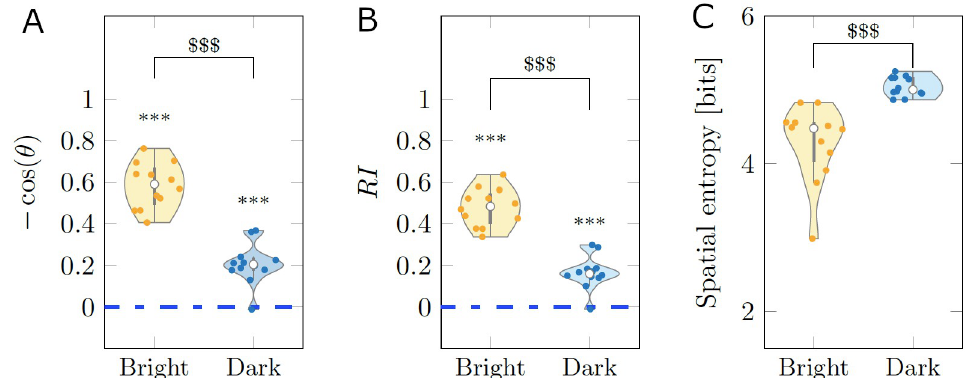
Fig 5. Average scoring of three behavioral metrics for in-silico experiments. (A-B) Rheotactic metrics taking values between − 1 and 1 corresponding to biased headings downstream and upstream, respectively. (C) Spatial entropy, measuring the exploratory behavior across the test section. The average was taken over synthetic time series of 9, 000 points for each experimental subject. The gray bar in each violin plot details median (white dot), first and third quartiles, and lower and upper adjacent values. The colored area of a violin plot corresponds to the probability density of the data. Symbol $$$ indicate significant difference between conditions p < 0.001, respectively.